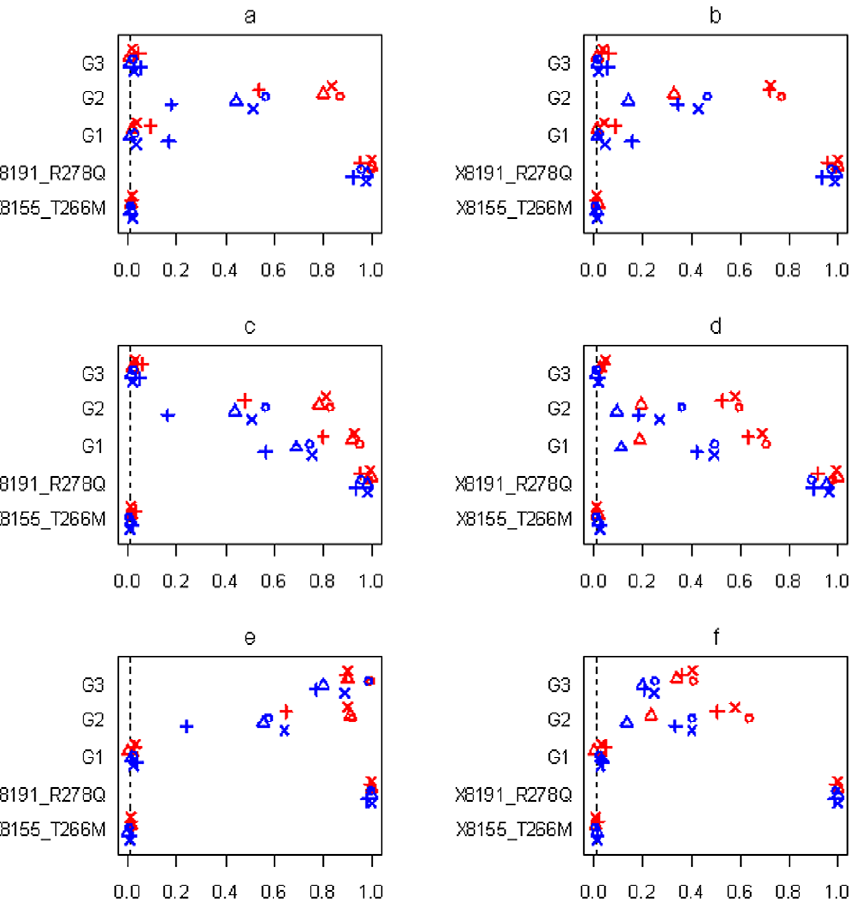
Figure 7. Simulations with sample size n=3,008 and three groups for the six scenarios (see Table 1). Power or Type I error rate for the proposed method ( # ), Yi and Zhi ( 6 ), Simple-Sum ( D ) and All-Variants ( + ) under the threshold level of 0.01. X8155_T266M and X8191_R278Q are the two common non-synonymous variants, and G1, G2 and G3 are the three group effects (G1: common synonymous; G2: rare non-synonymous; G3: rare synonymous). Red and blue symbols represent results for continuous and binary traits, respectively. The dashed line is the nominal 0.01 level.